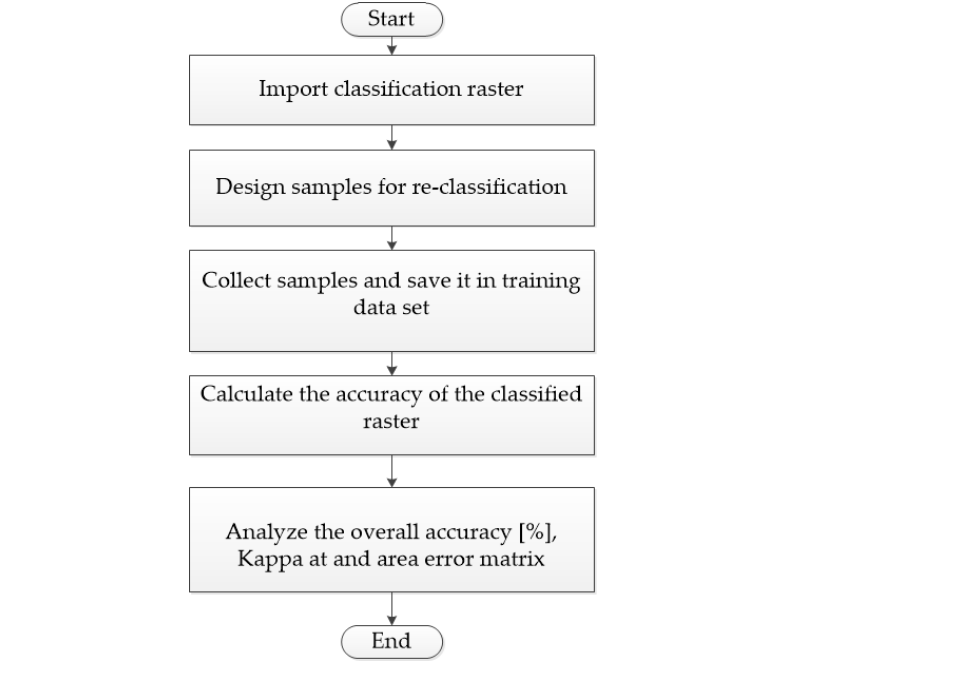
Table 2. Sub sample coordinates in WGS 84/UTM zone 42N system.